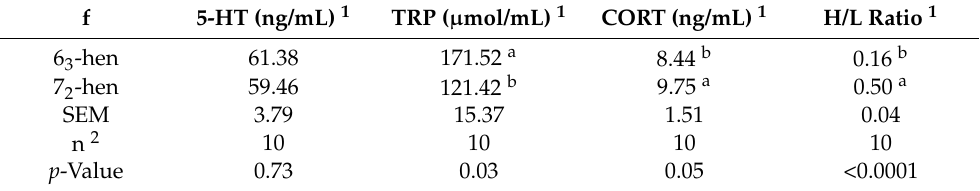
Figure 2. Alpha diversity of cecal content bacteria in two diversely selected chicken lines. Box-and-whisker plots of diversity within samples. ( A ): estimated number of amplicon sequence variants (ASVs) calculated by the Chao1 index, ( B ): alpha diversity calculated by the Shannon index, ( C ): species evenness calculated by the Pielou’s evenness measures; and ( D ): phylogenetic diversity calculated by Faith’s phylogenetic diversity (PD). Table 1. Peripheral serotonin, tryptophan, corticosterone and heterophil/lymphocyte ratio levels between two diversely selected chicken lines.